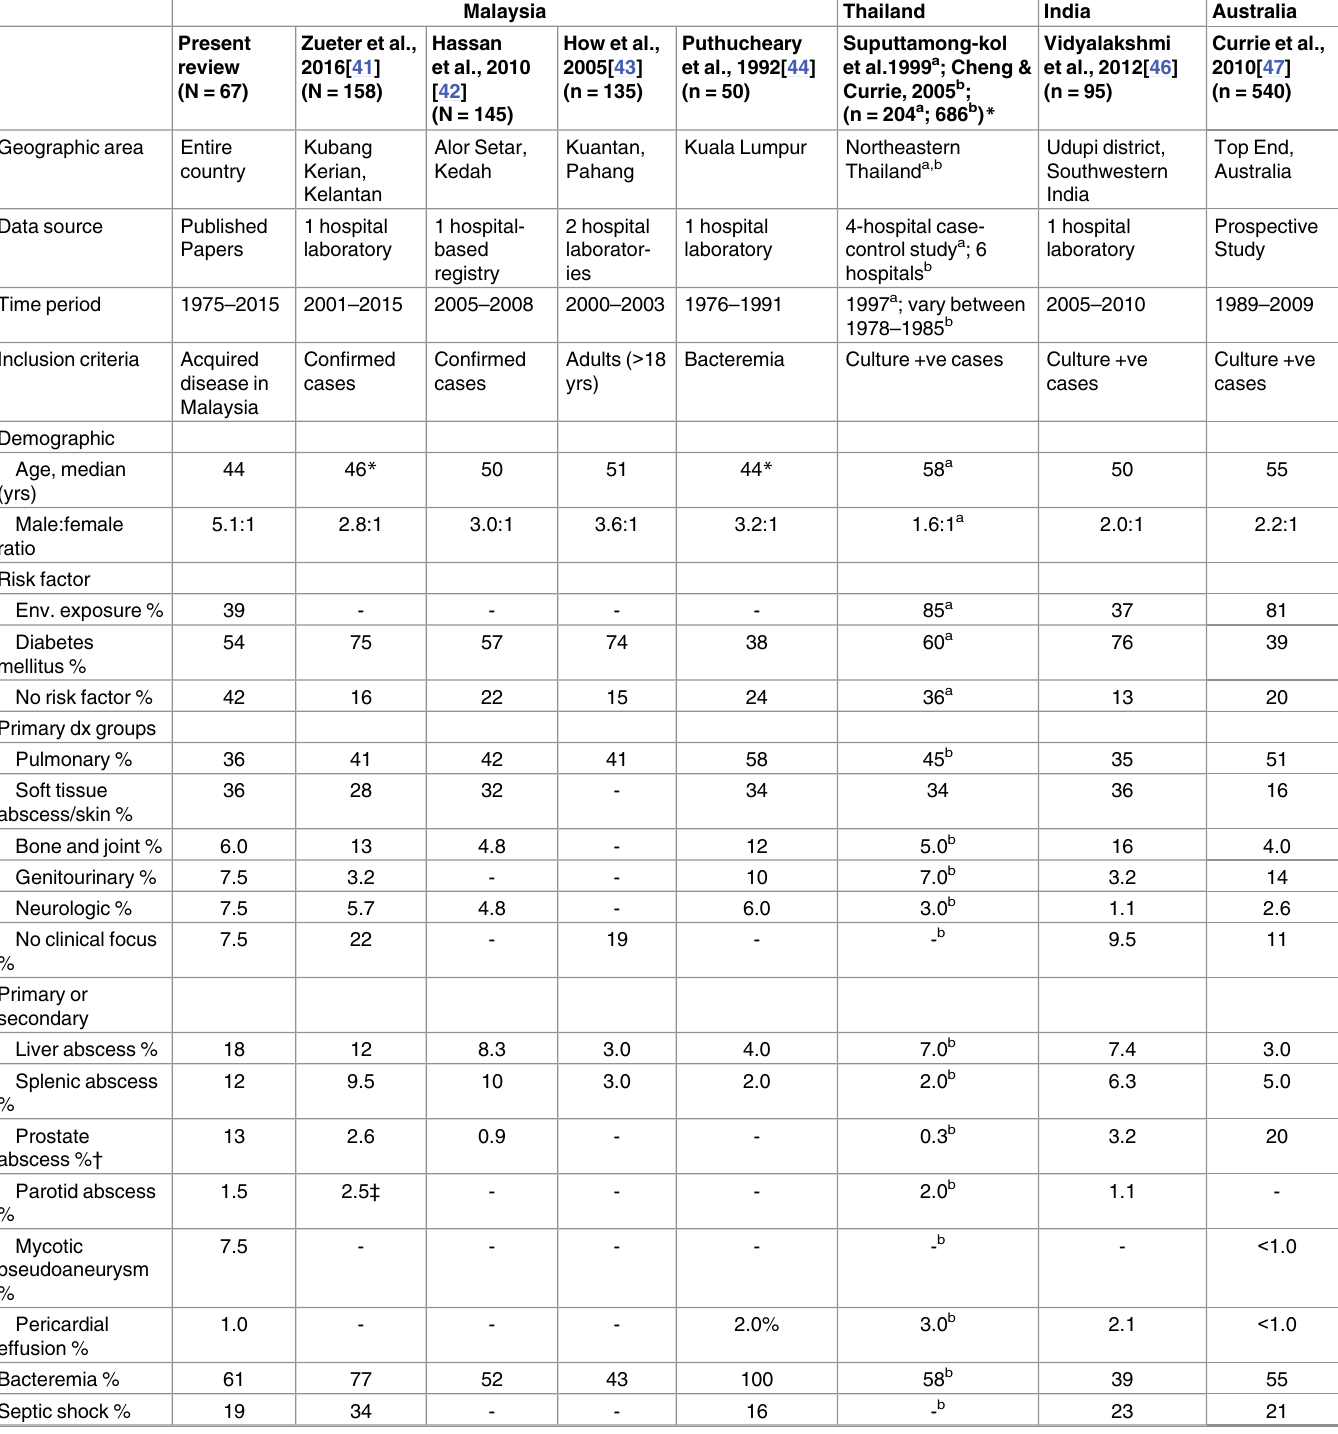
Table 7. Comparisons of selected results from the present case review and of previously published case reviews of from Malaysia, Australia, Thai land and